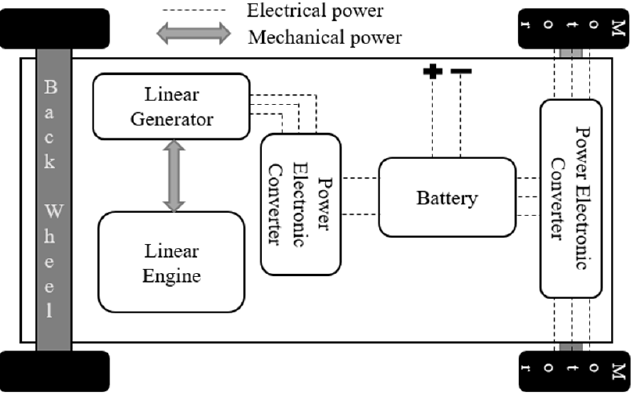
Figure 2. Proposed hybrid electric vehicle system powertrain.